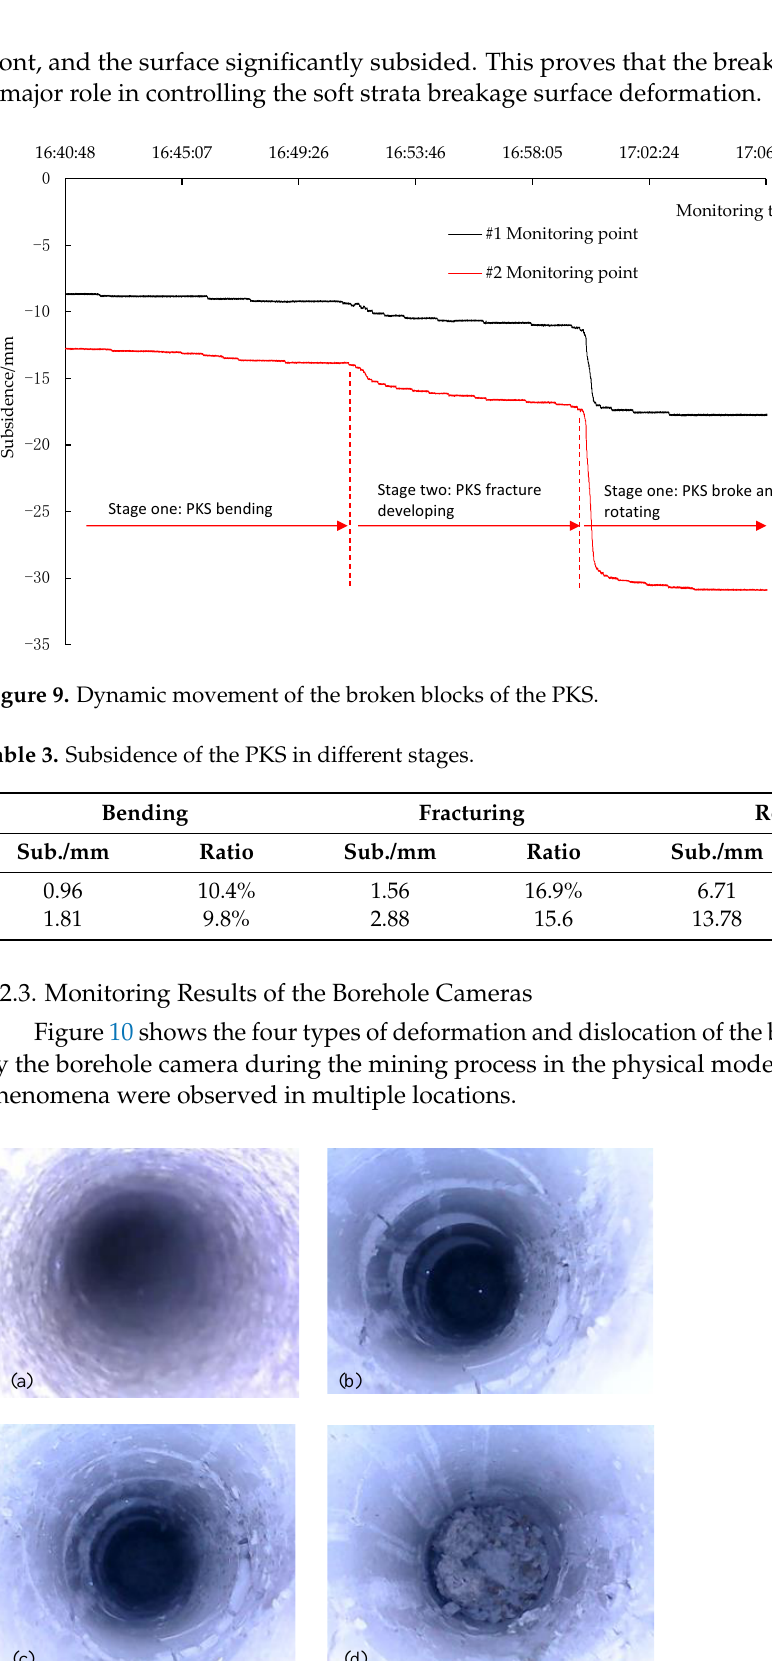
8 of 19 Figure 7. Subsidence of the monitoring points due to mining. ( a ) subsidence of the monitoring points 5 and 6; ( b ) subsidence of monitoring point 4. 3.2.2. Breakage of the PKS With the further advancement of the working face, the SKS periodically broke and the overhanging length of the PKS gradually increased. When the SKS broke again, cracks were observed in the middle of the suspended part of the PKS. Subsequently, the PKS completely broke, rotated and subsided, as shown in Figure 8a. After the breakage of the PKS, the bed separation space was transferred to the surface, and only part of the separa- tion space was reserved at both ends. Similarly, the breaking angle of the rock strata at the side of the working face was still greater than that at the cut hole. Fracture zone Bending zone Bending Break Bed separation Bed separation ( a ) ( b ) Figure 8. Breakage of the PKS. ( a ) first breaking; ( b ) periodical breaking.